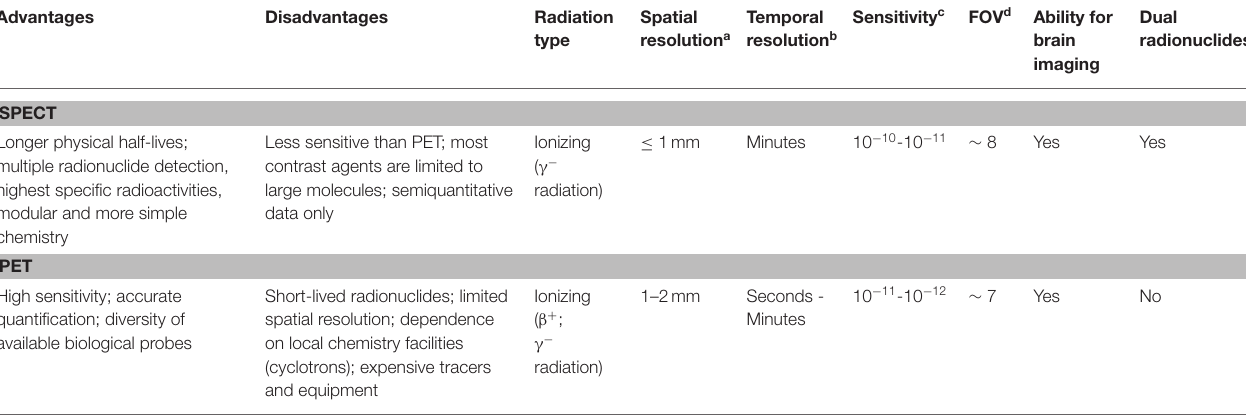
TABLE 1 | Performance comparison between SPECT and PET systems for preclinical imaging (adapted from Jansen and Vanderheyden, 2007). Advantages